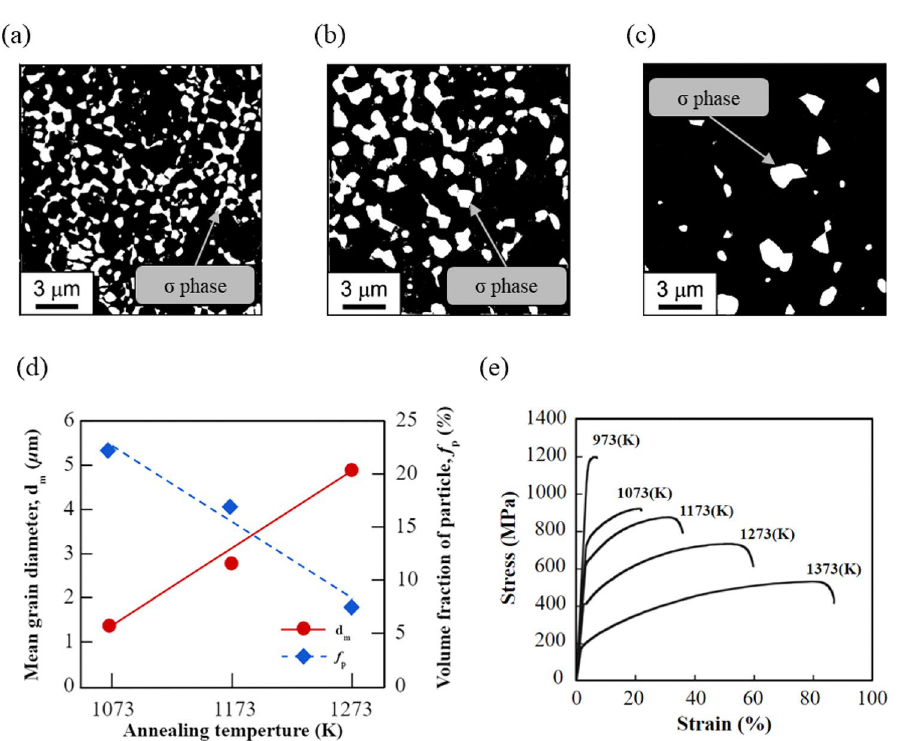
Figure 2. SEM-BSE images of the Co 20 Cr 25 Fe 20 Mn 20 Ni 15 alloy annealed at ( a ) 1073 K, ( b ) 1173 K, and ( c ) 1273 K for one hour after 90% cold rolling. ( d ) Variation in the mean grain diameter and the volume fraction of the 25Cr as a function of annealing temperature. ( e ) The stress strain curves of the 25Cr annealed at different temperatures for one hour. (The raw data of the SEM-backscattered electron (BSE) images and the stress–strain curves for the CoCrFeMnNi alloy annealed at different temperatures were obtained from Cho et al. 24 The data was extracted and reproduced in the present